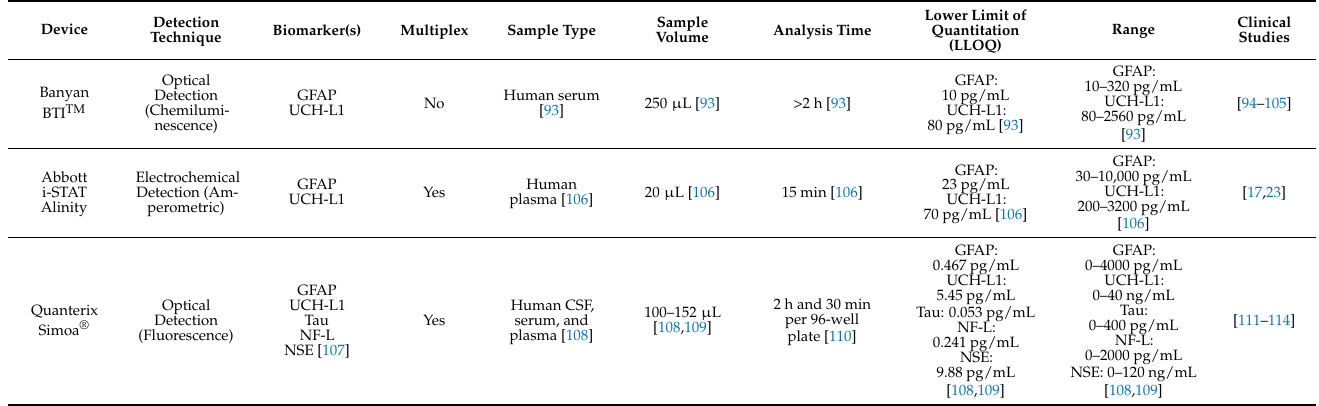
Table 3. Summary of late-stage sensors for traumatic brain injury protein biomarker measurement.